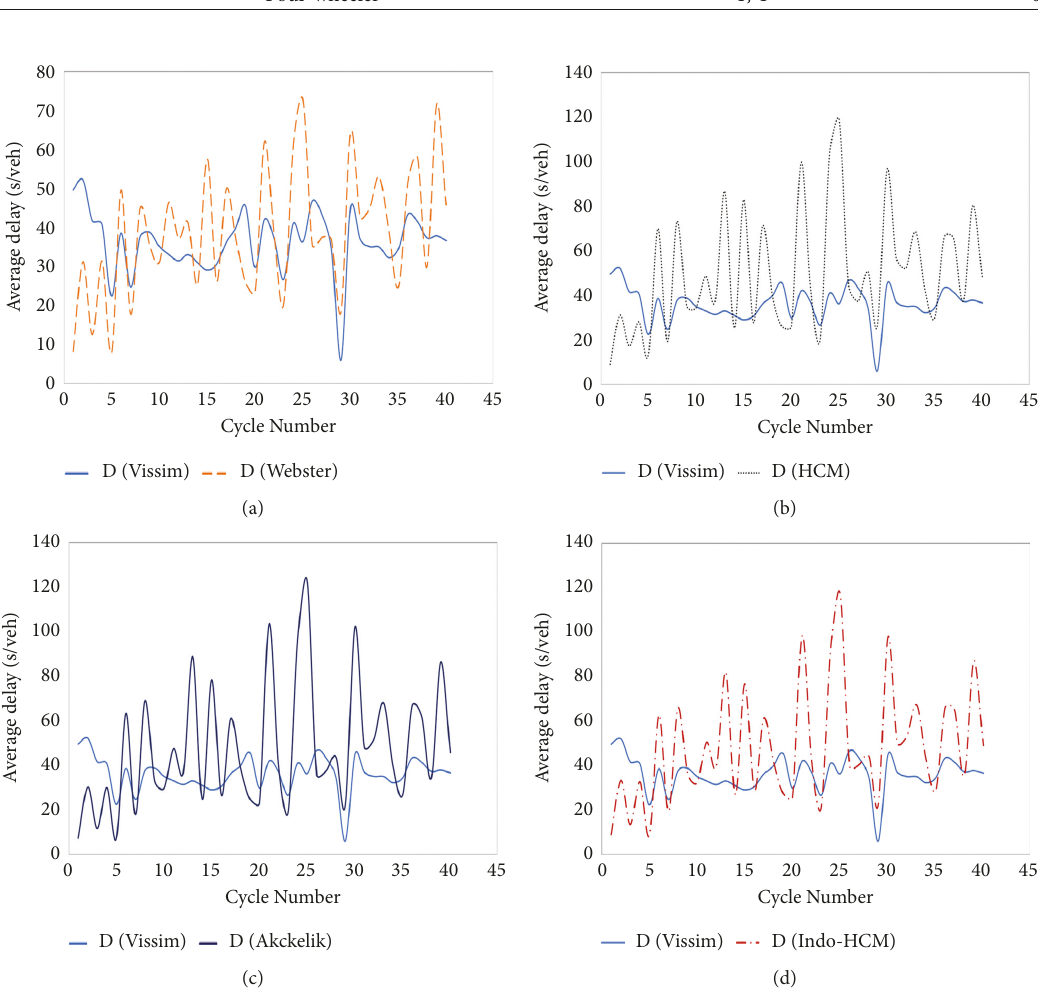
Figure 2: Comparison of delay estimates from delay models and simulation. (a) Webster’s model (MAPE � 64.8%). (b) HCM model (MAPE � 79.9%). (c) Akcelik’s model (MAPE � 80.2%). (d) Indo-HCM model (MAPE � 78.8%).